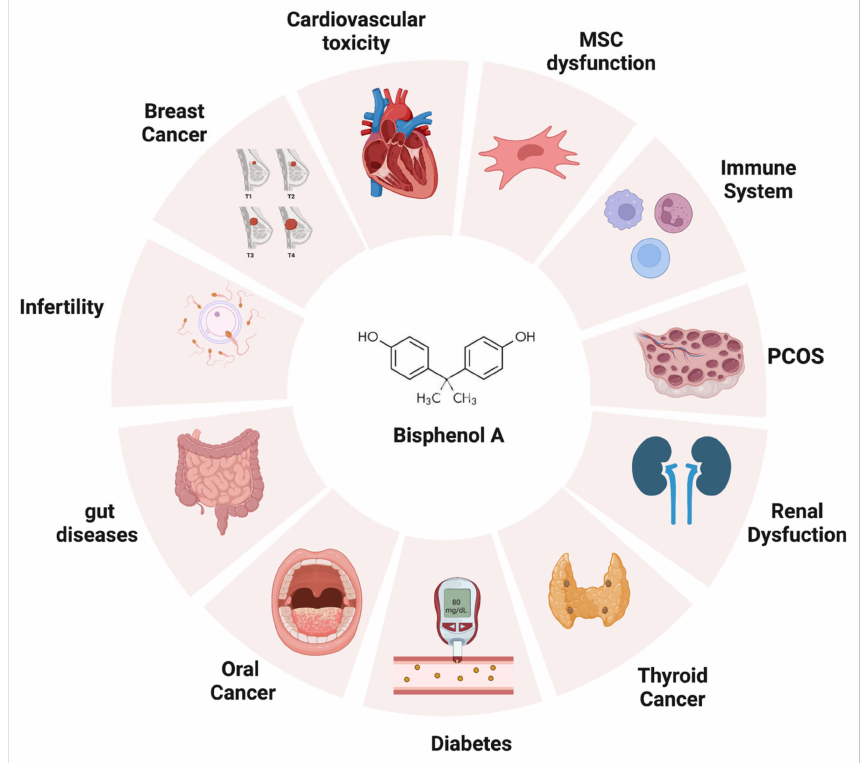
Figure 2. The adverse effects of bisphenol A on human health. BPA can negatively impact different targets once introduced into the human body, such as thyroid, heart, reproductive apparatus, gut, immune system, and kidneys (created with